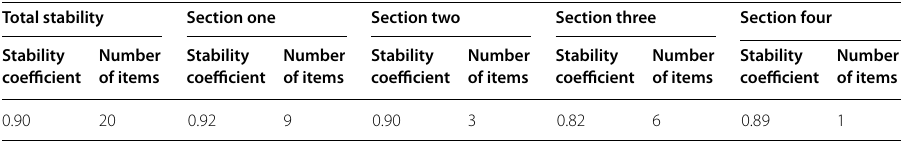
Table 1 Cronbach’s alpha of the questionnaire and its sections Total stability Section one Section two Section three Section four Stability Number Stability Number Stability Number Stability Number Stability Number coefficient of items coefficient of items coefficient of items coefficient of items coefficient of